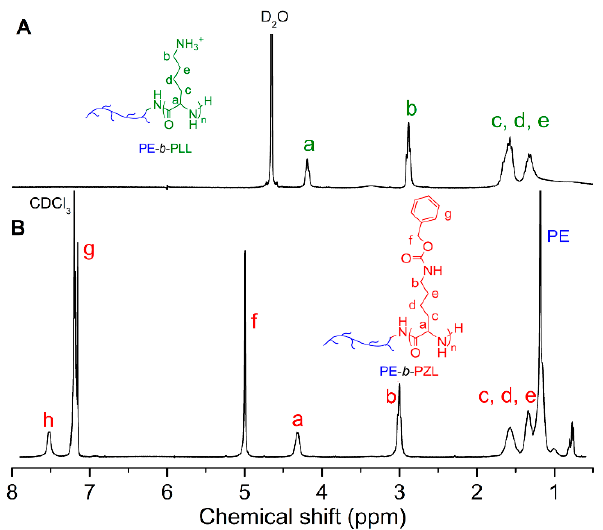
Figure 2. 1 H NMR spectra of ( A ) PE 607 - b -PLL 275 in D 2 O and ( B ) PE 607 - b -PZL 275 in CDCl 3 .